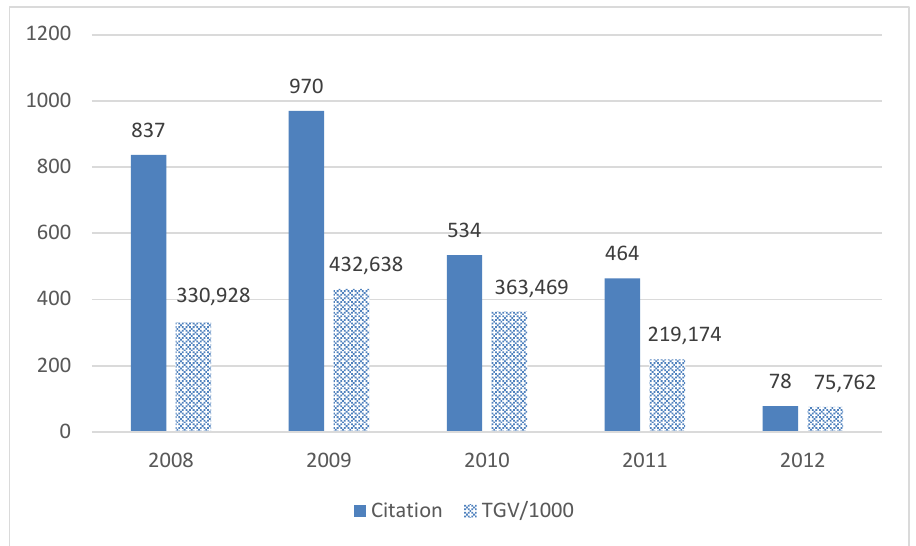
Figure 5. Frequencies of citations and total galley views (TGV/1000) by years of publication in selected highly cited